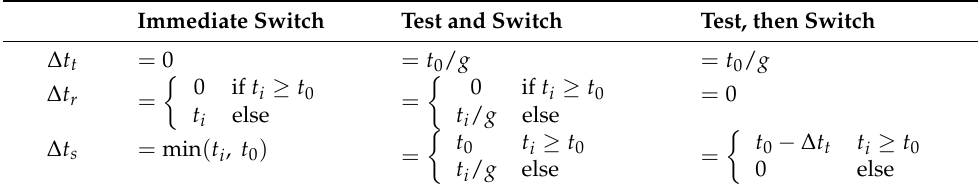
Table 1. Dependencies of the timespans and switching